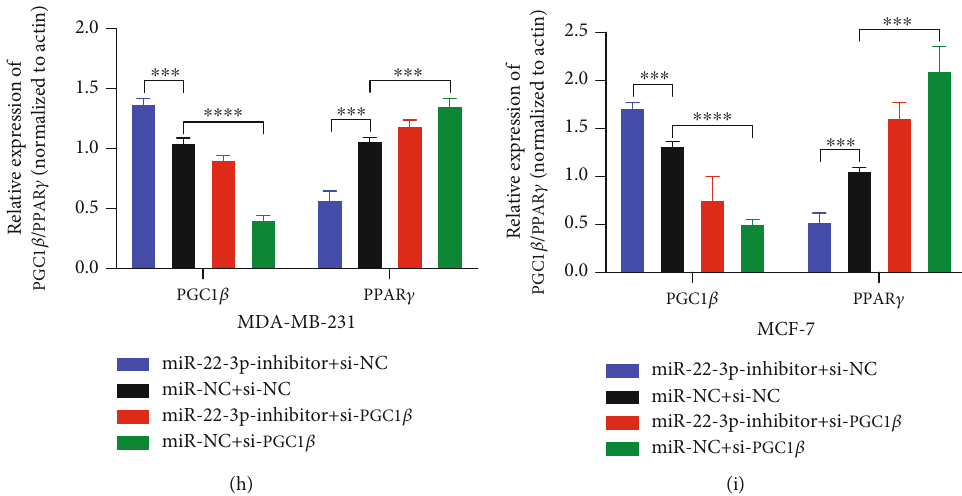
Figure 5: miR-22-3p suppressed the proliferation and migration of BC cells via PGC1 β . (a – d) Knockdown of PGC1 β partially reversed miR- 22-3p inhibitor-induced promotion of proliferation in MDA-MB-231 and MCF-7 cells determined by MTT assay and colony assay. (e, f) Knockdown of PGC1 β partially reversed miR-22-3p inhibitor-induced promotion of migration in MDA-MB-231 and MCF-7 cells determined by transwell assay. (g – i) Western blotting analysis for PGC1 β /PPAR γ protein level in MDA-MB-231 and MCF-7 cells. ∗ p < 0 : 05 ; ∗∗ p < 0 : 01 ; ∗∗∗ p < 0 : 001 ; ∗∗∗∗ p < 0 : 0001